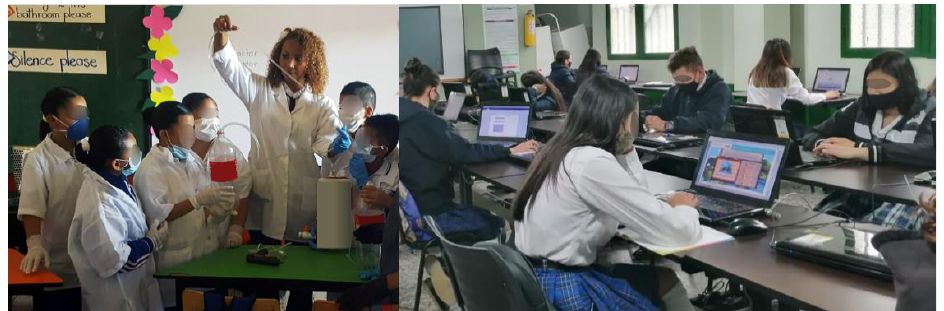
Figure 12. Meaningful experiences developed through Open Biotec . Left: biogas production experi- ment with rural elementary students (2019). Right: Pilot implementation of the virtual formation in biotechnology with secondary students (2020).